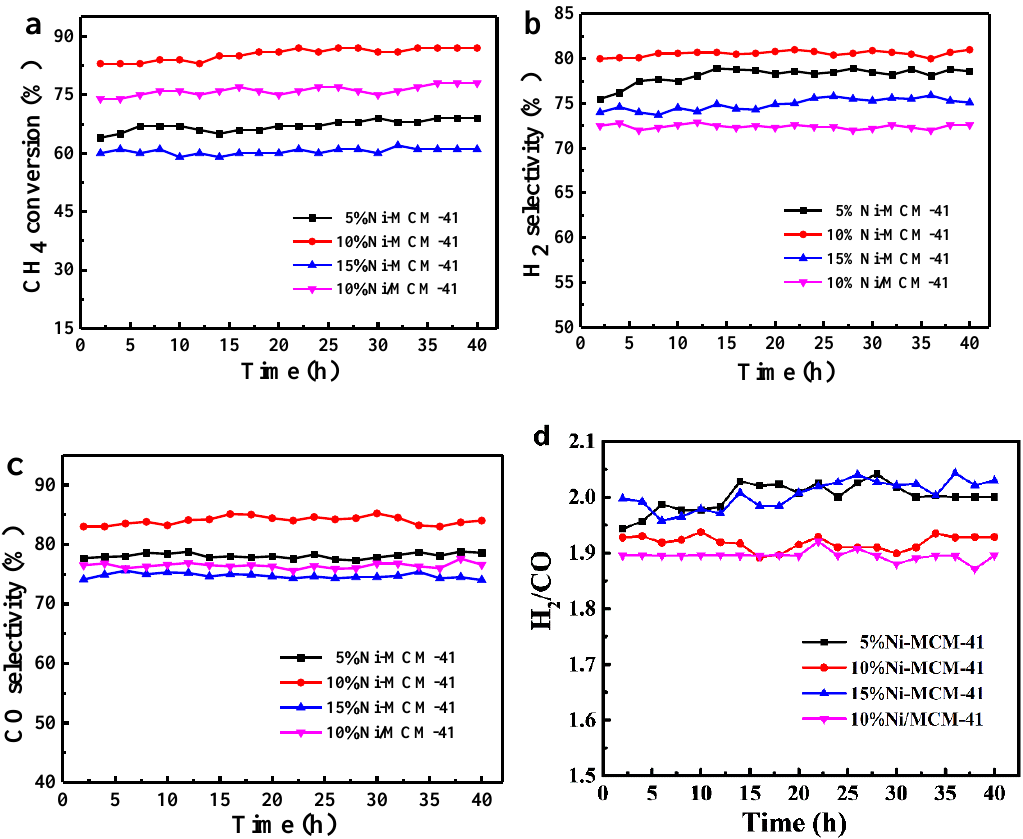
Figure 7. The catalytic ability comparison of the Ni / MCM-41 and Ni-MCM-41 in POM at GHSV = 1.8 × 10 4 mL·g − 1 ·h − 1 , atmospheric pressure, 750 °C. ( a ) CH 4 conversion, ( b ) H 2 selectivity, ( c ) CO selectivity and (d) H 2 / CO ratio.